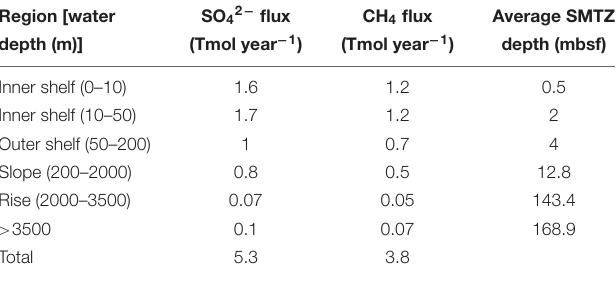
TABLE 2 | Global estimate of diffusive CH 4 and SO 42 − flux based on 1:1.4 ratio, and average SMTZ depth compiled from 740 sites (Egger et al., 2018). Region